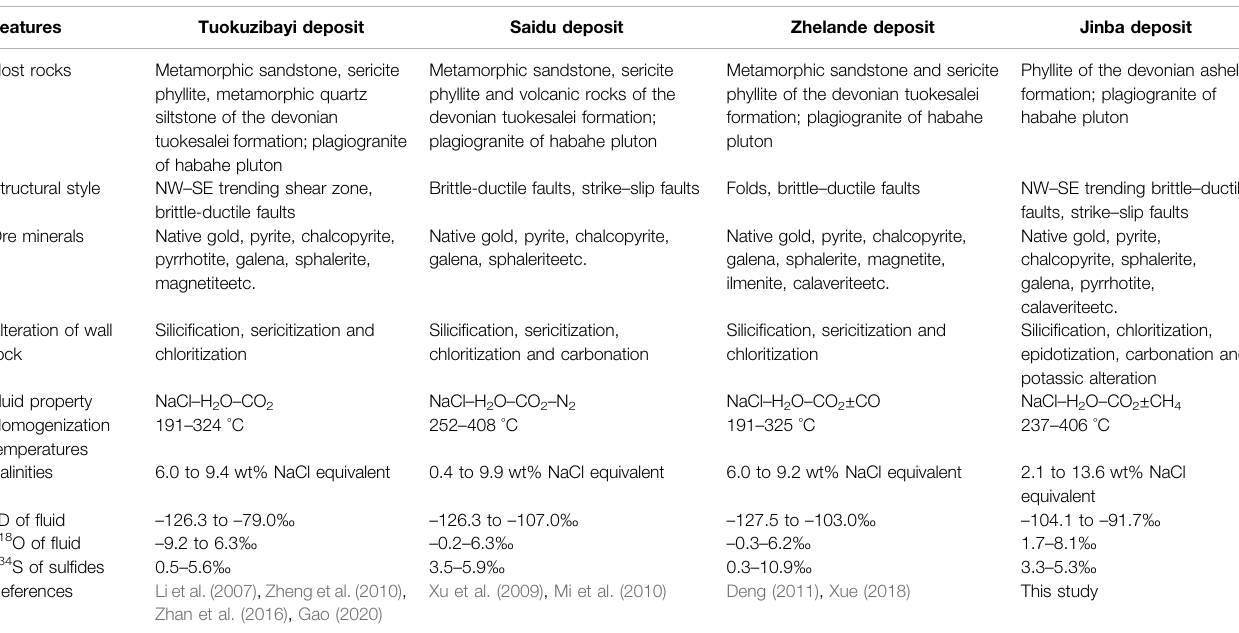
TABLE 5 | Comparison of general features of gold deposits in the Maerkaluli Shear